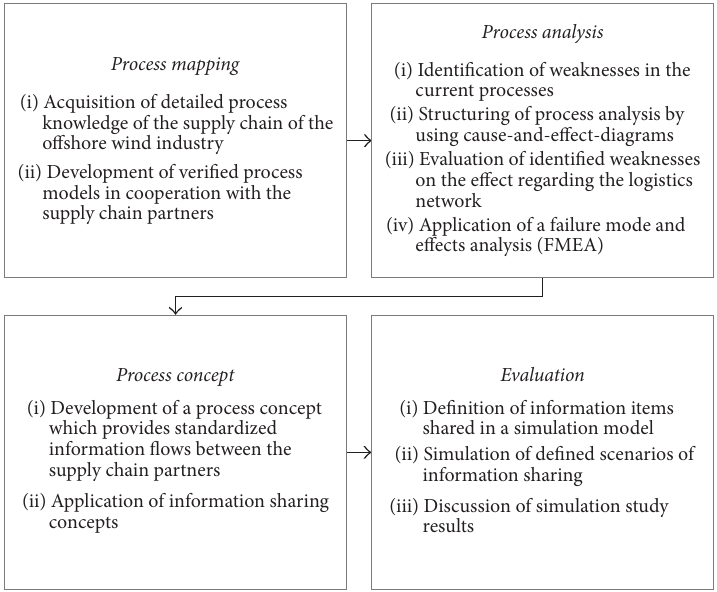
Figure 2: Approach for developing standardized information flows.